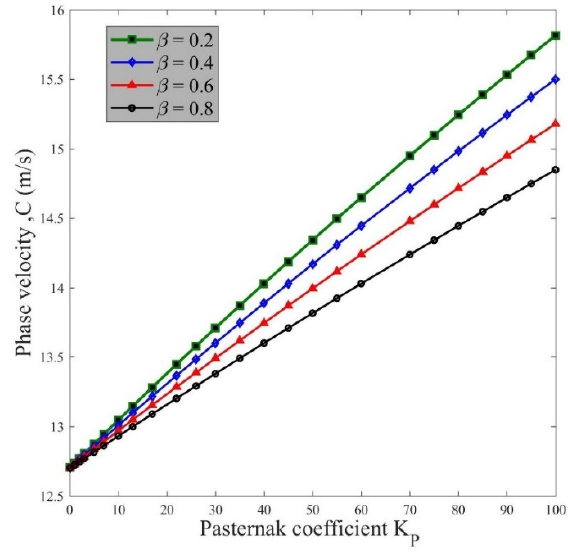
Figure 7. Phase velocity vs. Pasternak parameter for different β .